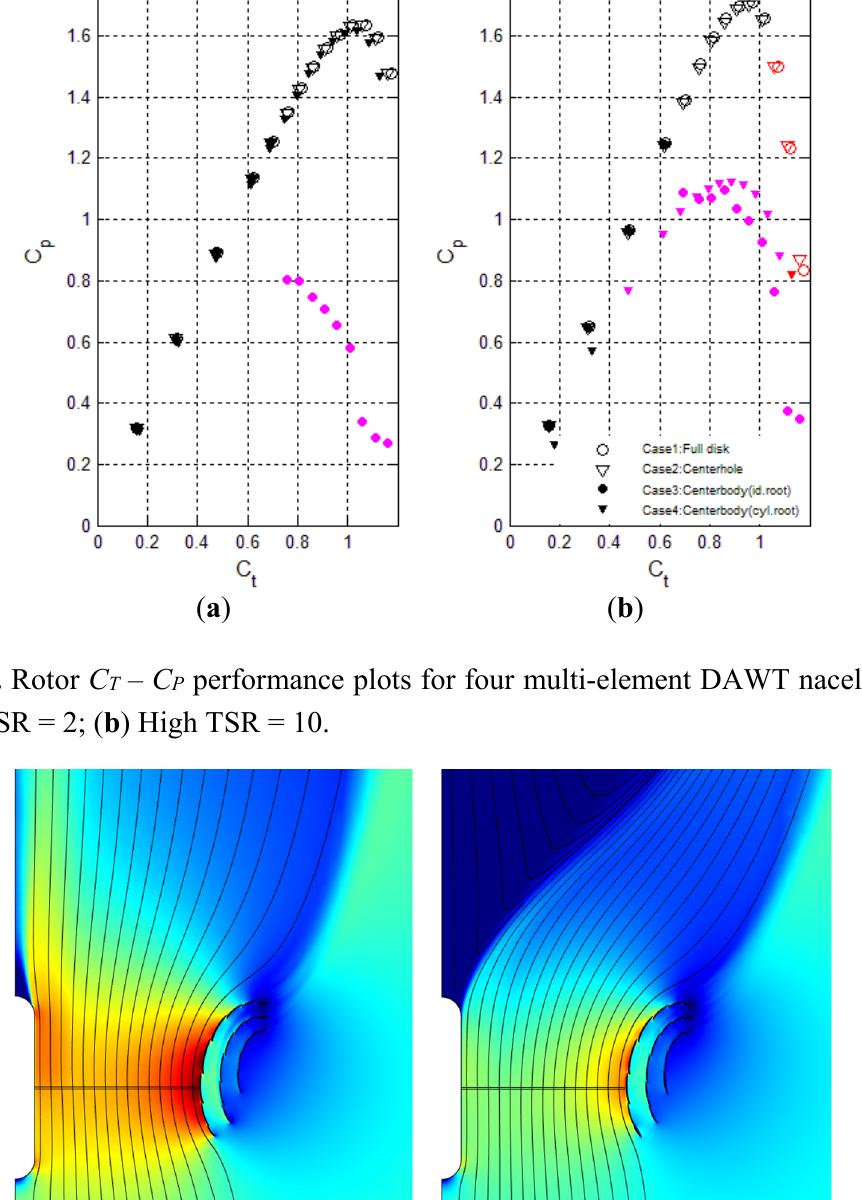
(cid:3404) 1.04 ; ( b ) TSR = 10, (cid:2904)